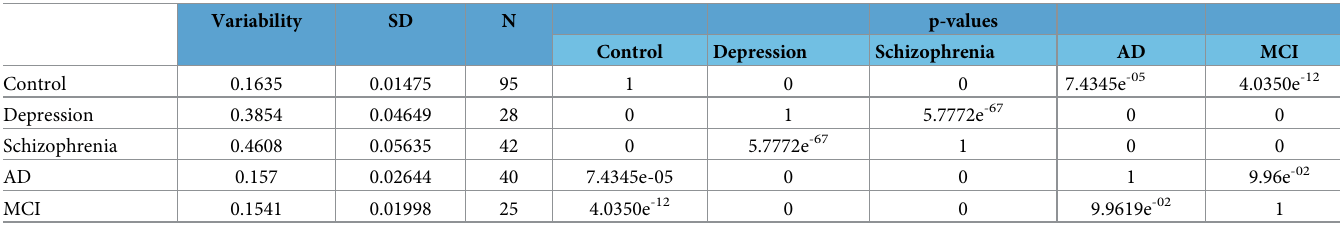
Table 3. Variability of quantum potential for participants